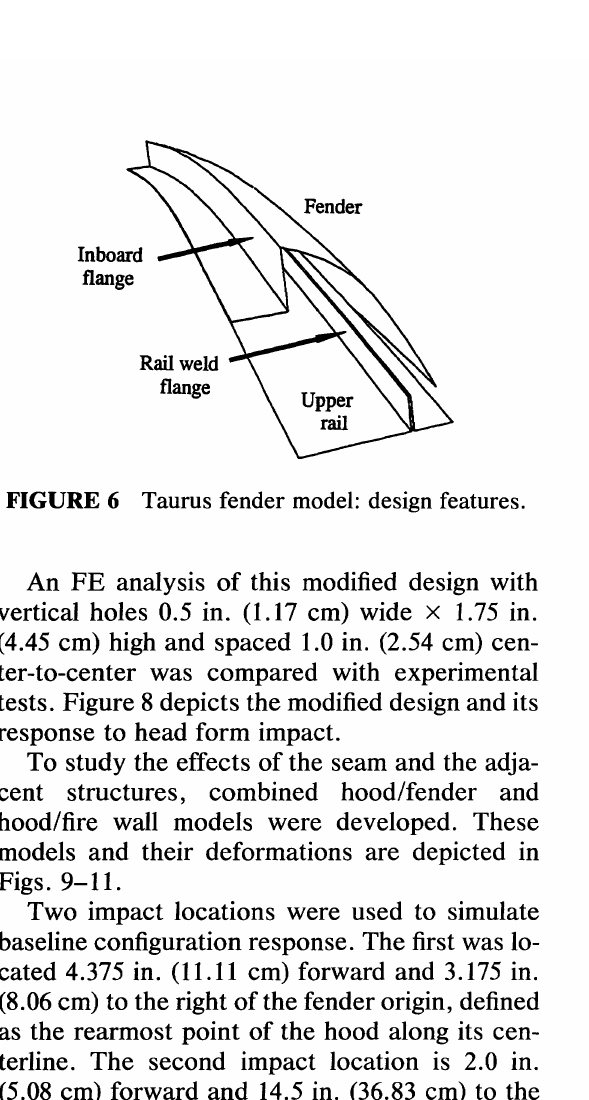
FIGURE 9 Baseline Taurus hood/fender model: de formations.